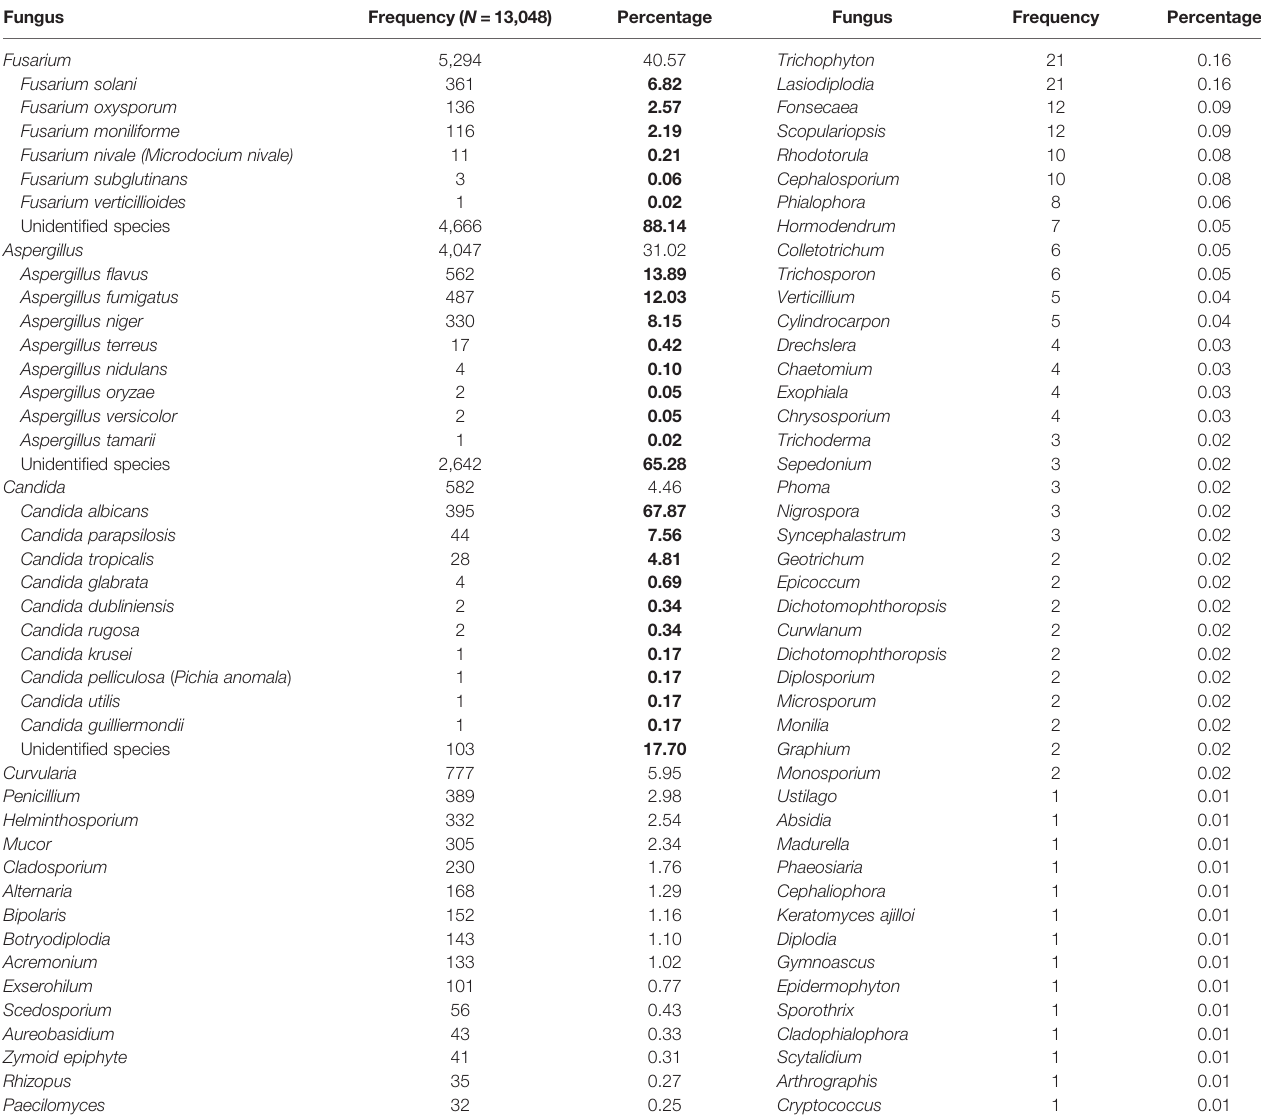
TABLE 3 | The spectrum and frequency of various fungi isolated from patients with suspected microbial keratitis and identi fi ed at the genus/species level during 1990 to 2020 (13,048 out of 15,295 isolates have been identi fi ed).